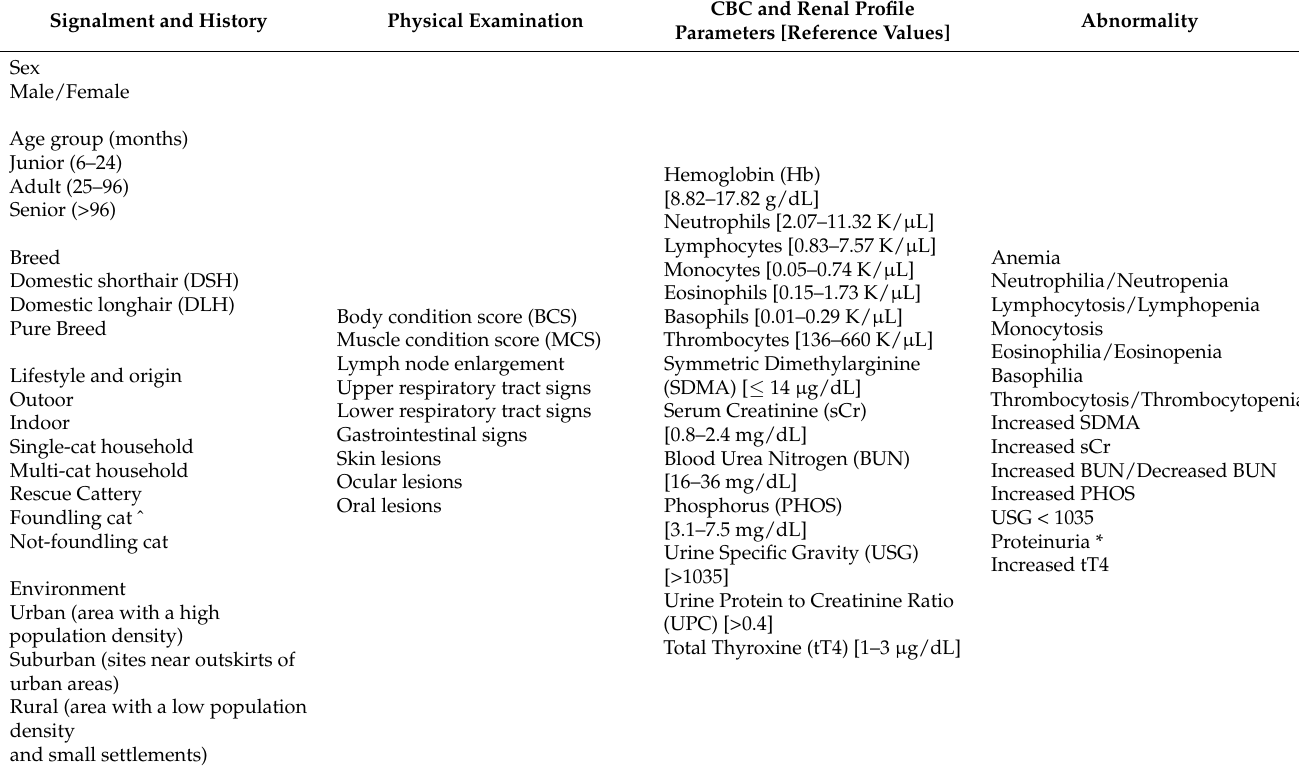
Table 1. List of variables statistically evaluated (apart from total thyroxine) in the enrolled cats concerning: signalment and history, physical examination findings, complete blood count (CBC) and renal profile parameters with their reference values, and abnormalities considered of clinical interest. *: values ≥ 0.2 ≤ 0.4 were evaluated as border-line proteinuria; ˆ foundling cat: stray or abandoned cat adopted months or years before the enrollment in this study. Signalment and